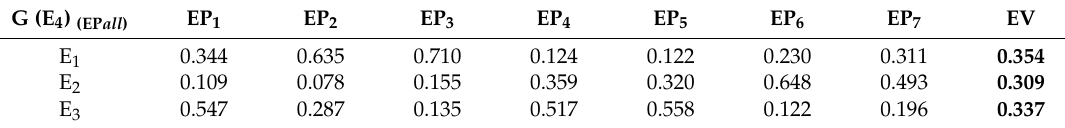
Table 3. EV values of E 1 , E 2 and E 3 of the integrated expert group targeting target G (E 4 ). G (E 4 ) (EP all )